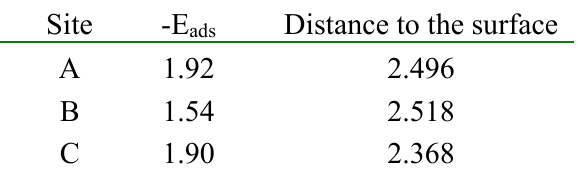
Table II. Adsorption energies (eV) and Au - surface distances (Å) computed from periodic GGA DFT calculations for coverage of 0.25 ML.